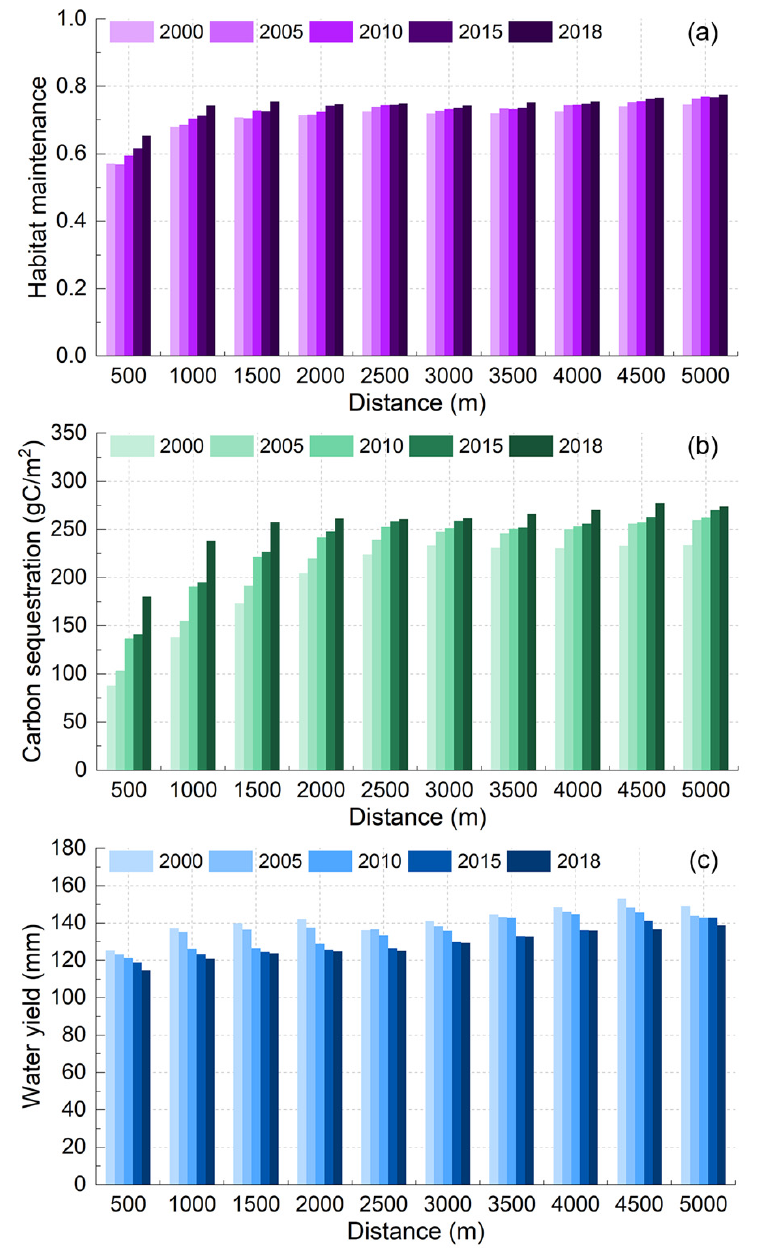
Figure 6. The change in considered landscape functions in buffers of the urban periphery of Liaoyuan city from 2000 to 2018. ( a ) Habitat maintenance; ( b ) Carbon sequestration; ( c ) Water yield. However, the impact of urbanization on these functions is spatially variable. We found that the magnitude of change in both the increase in CS and HM functions and the decrease in WY functions is more pronounced in the buffer zone at the edge of the city (Figure 6). For example, in the 500 m buffer (i.e., in the area 0–500 m from the urban edge), the HM and CS functions increased by 14.79% and 105.57%, respectively, while the WY function decreased by 8.42% during 2000–2018 (Figure 6). In contrast, in the 5000 m buffer zone (i.e., in the area 4500–5000 m from the urban edge), the HM and CS functions in- creased by 3.87% and 17.19%, respectively, while the WY function decreased by 7.06% during 2000–2018 (Figure 6). In fact, the magnitude of change in HM function is already relatively similar in the buffer zone beyond 1000 m from the urban edge (Figure 6a). By comparison, it is beyond 2500 meters that the CS function grows at a progressively similar magnitude (Figure 6b). Thus, the response of forest landscape functions to urbanization is inconsistent in terms of both magnitude of change and distance. Within distance gradients of the urban periphery, forest landscape multifunctionality is predicted to respond differently to ur- banization. 3.3. Effects of Urbanization on Forest Landscape Multifunctionality As predicted, there is a gradient effect in the response of urban peripheral forest land- scape multifunctionality (UPFM) to urbanization (Figure 7). From 2000 to 2018, the UPFM in the 500 m, 1000 m, 1500 m, and 2000 m buffer zones decreased by 39.24%, 5.99%, 5.20%,